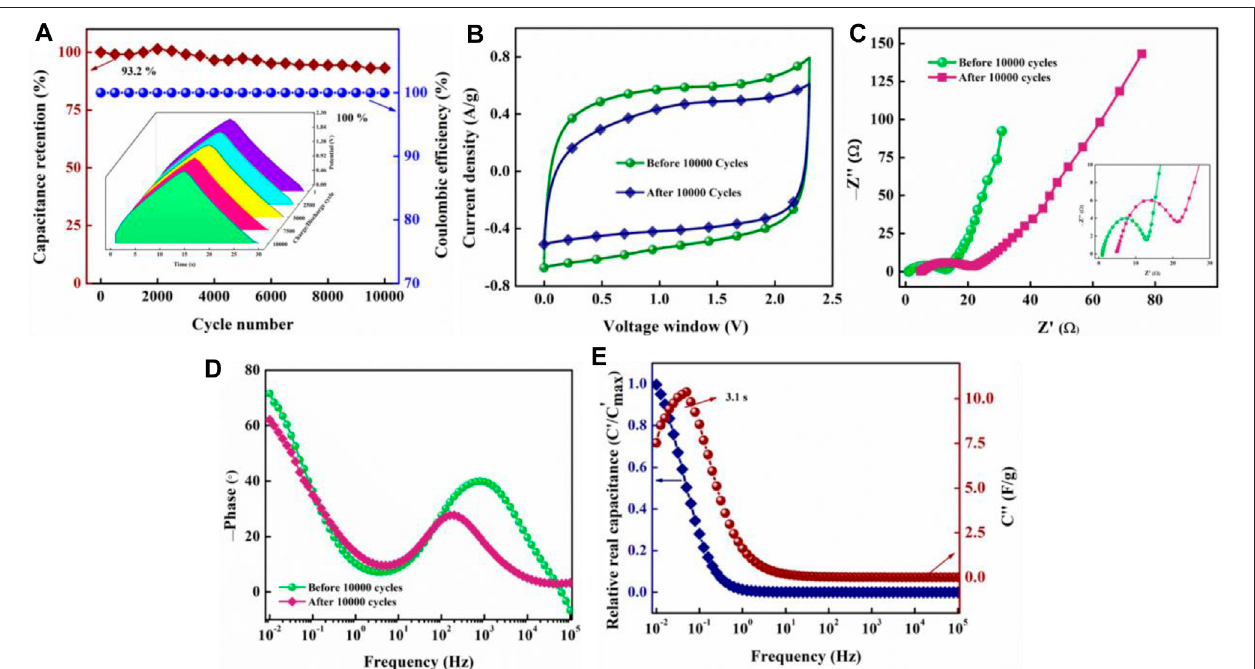
FIGURE 10| Capacitance retention (%)and coulombic ef fi ciency (%) over the charge/discharge cycle number ofOSSc (A) ; the insetshows the charge – discharge curves measured at various cycle numbers during stability study; CV curves (B) and Nyquist impedance plot (C) of OSSc before and after 10,000 charge/discharge cycles;theinsetin (C) showstheplotatthehigh-frequencyregion;Bodephaseangleplotasafunctionoffrequency (D) ;relativereal(C ′ )andimaginary(C ″ )capacitance over frequency (E) .